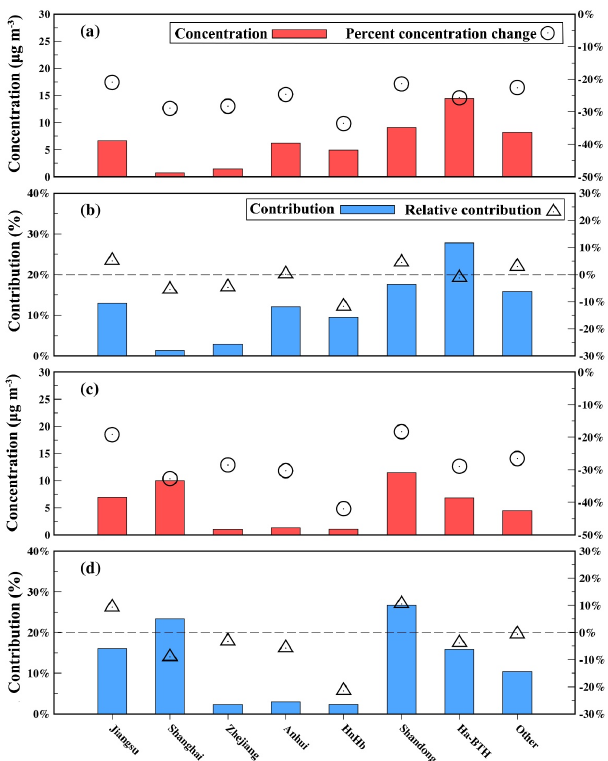
Figure 7. Concentrations and contributions of predicted PM 2 . 5 from different regions in the YRD (a, b) and Shanghai (c, d) of case 2, corresponding to the left y axis and the relative change (corresponding to the right y axis) from 23 January to 28 Febru- ary 2020. The meanings of relative contribution and percent con- centration change are the same as in Fig.